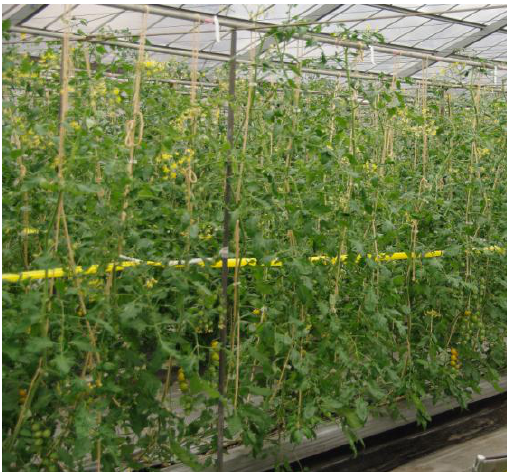
Figure 1. Photograph of tomato ( Lycopersicon esculentum Mill.)